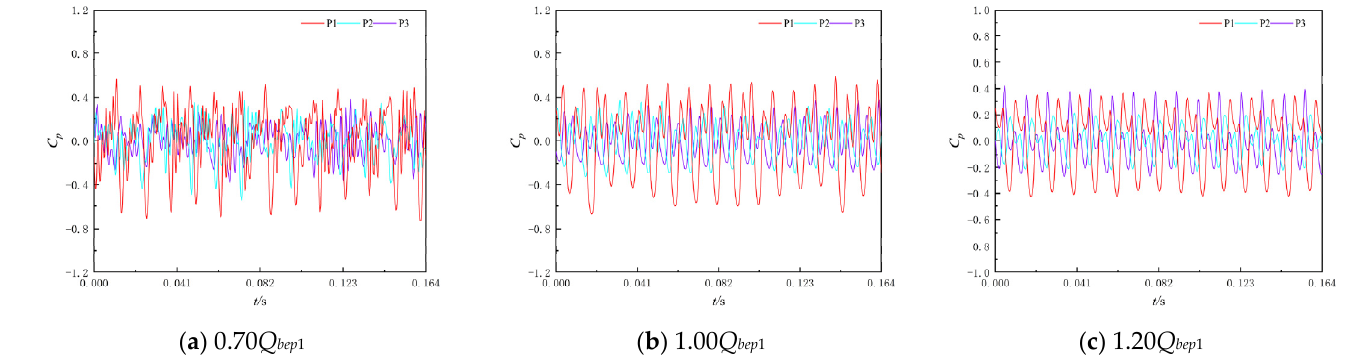
Figure 10. Time domain diagram of pressure fluctuation coefficient of each monitoring point under forward operation condition.